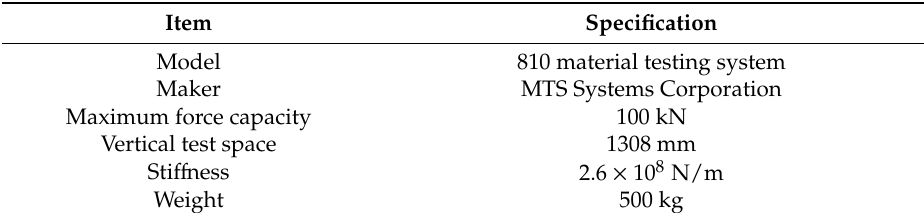
Table 2. Exciter specifications.